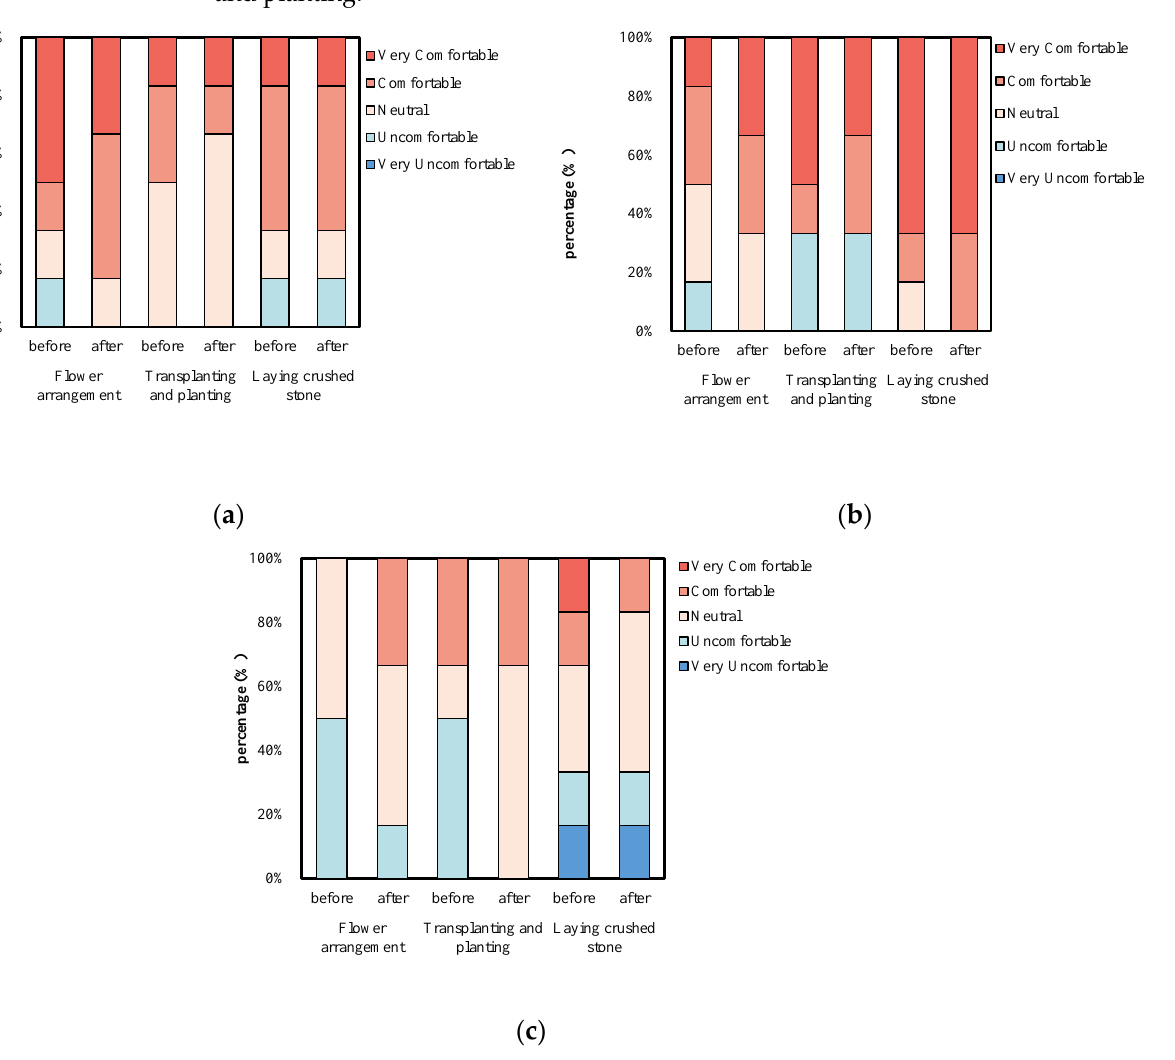
Figure 6. Percentage change of TCV before and after horticultural activities ( a ) PA, ( b ) TS, and ( c ) OS.